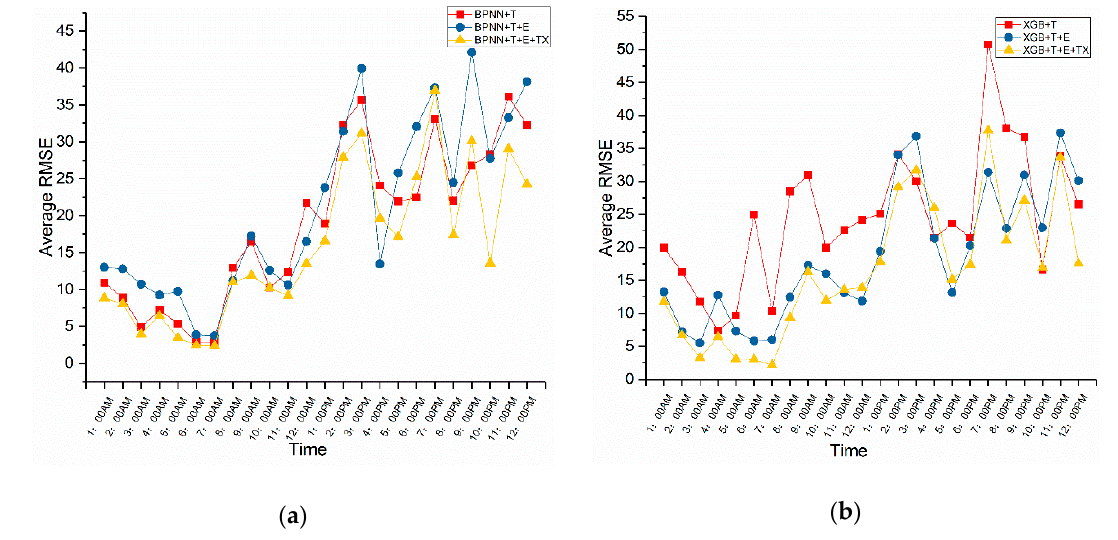
Figure 7. Average mean absolute percentage error (MAPE) of online taxi-hailing demand prediction based on BPNN and XGB in different hours. ( a ) MAPE of the prediction models based on BPNN; ( b ) MAPE of the prediction models based on XGB.